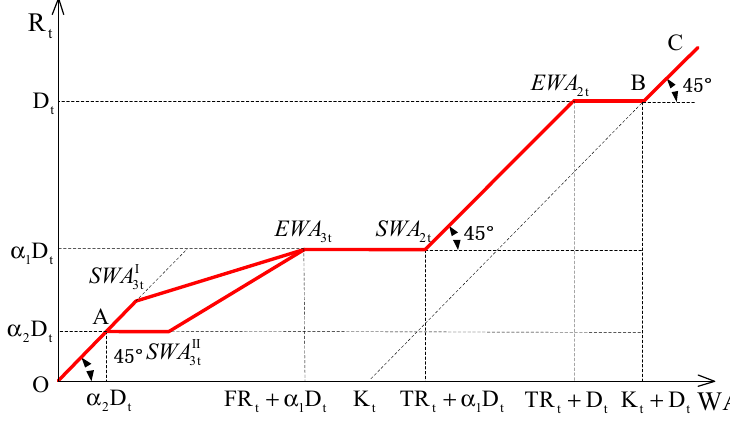
Figure 4. The derived optimal hedging policy for Rule 2.